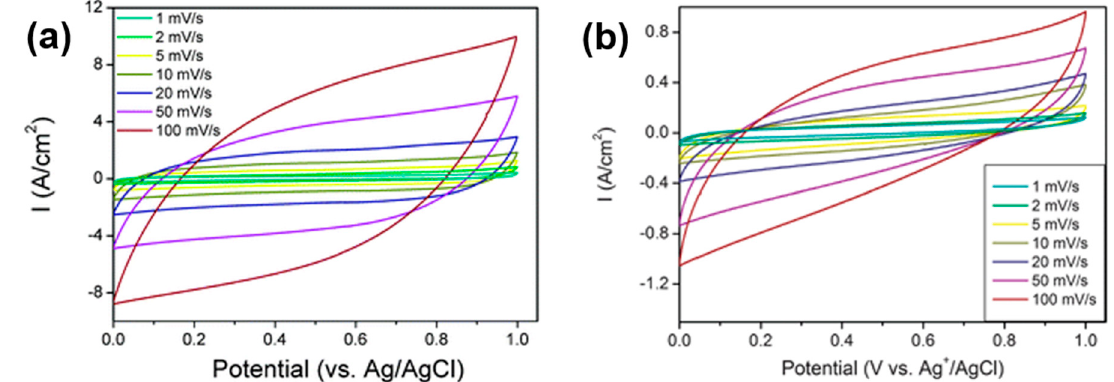
Figure 6. Cyclic voltammetry (CV) curves obtained from mNiMn 2 O x -600 ( a ) and mNiCoMnO 4 -800 ( b ) electrode with different scan rates (1 to 100 mV/s) in 0.1 mol/L Na 2 SO 4 at room temperature. [63,64]. Reprinted with permission from The Royal Society of Chemistry.